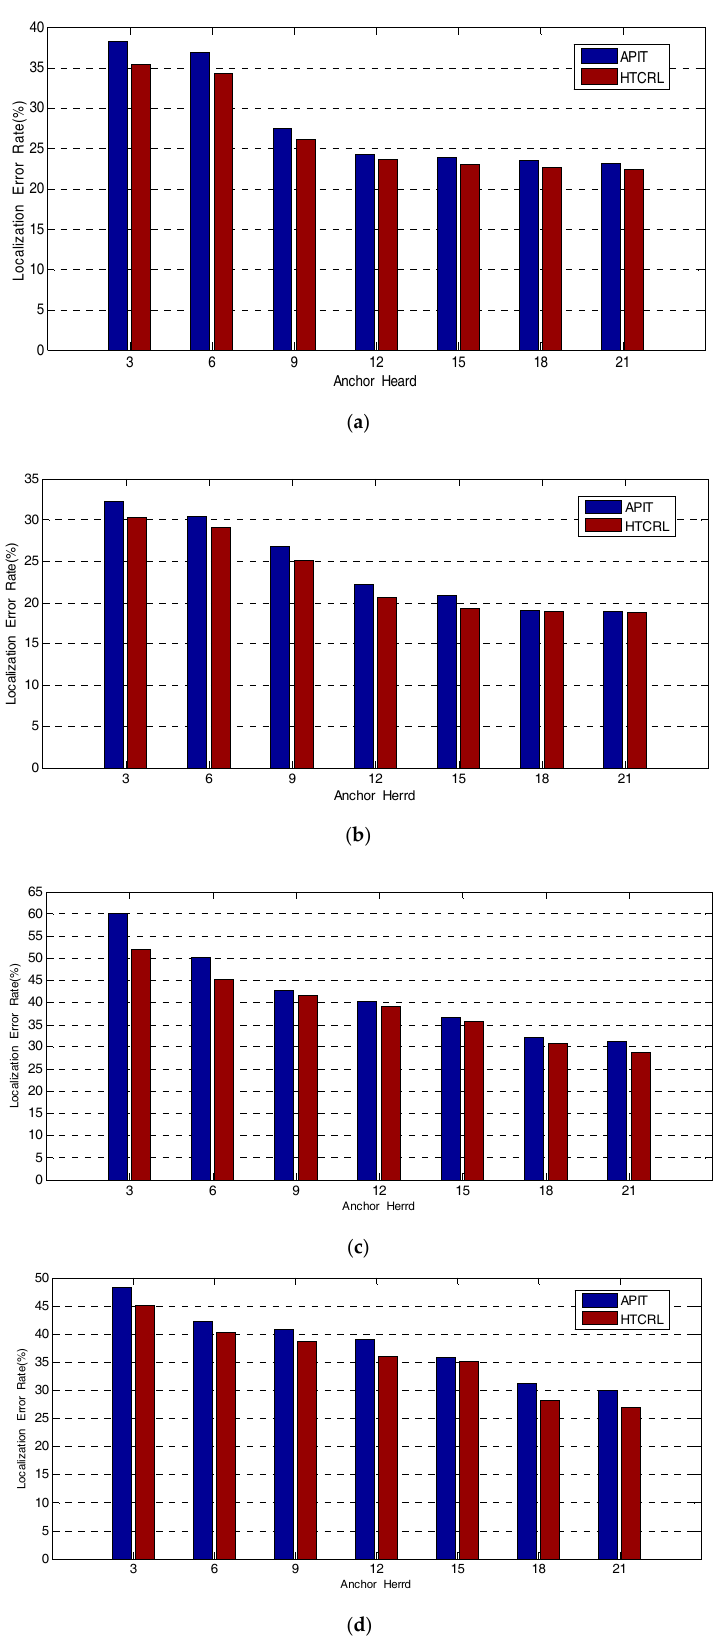
Figure 11. Localization Error Rate Varying with Anchor Heard. ( a ) AH = 3~21, ANR = 3, ND = 8, R = 150, Random, K = 0.0050; ( b ) AH = 3~21, ANR = 3, ND = 8, R = 150, Uniform, K = 0.0050; ( c ) AH = 3~21, ANR = 3, ND = 8, R = 450, Random, K = 0.0050; ( d ) AH = 3~21, ANR = 3, ND = 8, R = 450, Uniform, K = 0.0050.